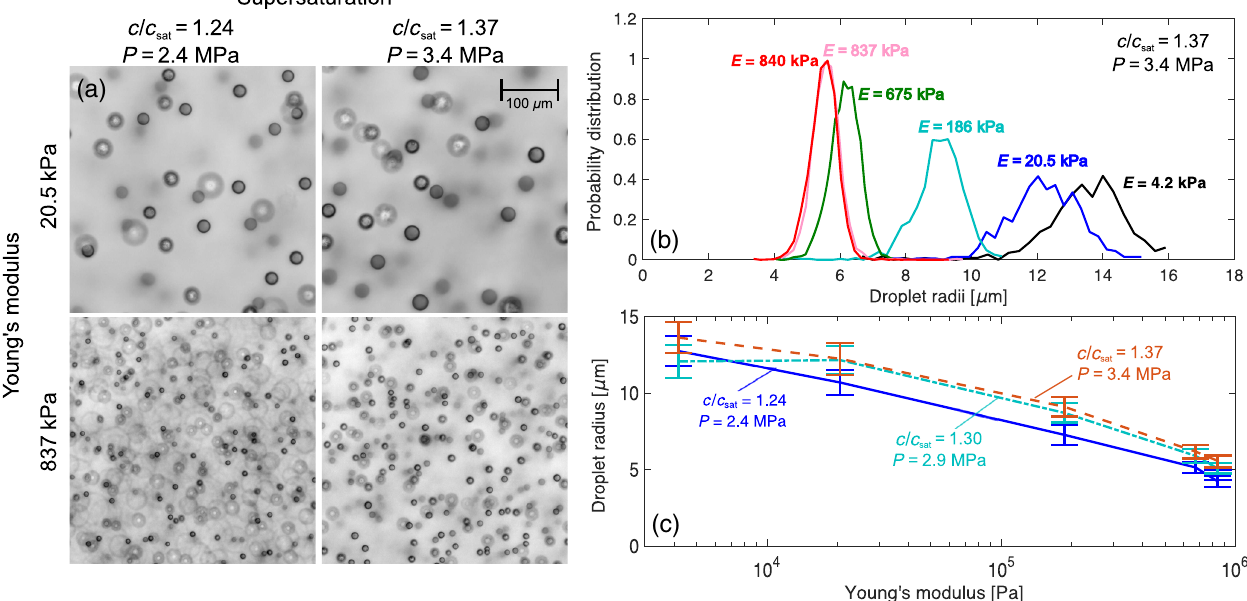
FIG. 2. Droplets formed by phase separation of fluorinated oil in silicone gels. (a) Examples of droplets formed in a soft (top) and stiff (bottom) gels. Examples in the left column have a lower loading than the right column, as they are saturated at 37 /44 °C respectively, before being cooled at a rate of 1 . 5 °C/ min to 23 °C. Note that some of the droplets appear to have other droplets embedded within them, or some sort of substructure. In fact, this corresponds to the imaging of other droplets that lie behind the current plane of focus. (b) Examples of typical droplet distributions in different stiffness gels, each saturated at 44 °C. (c) The dependence of droplet size on stiffness and saturation temperature. Data points are centered on the average value, and the error bars indicate the standard deviation. In each panel, P is calculated using Eq.